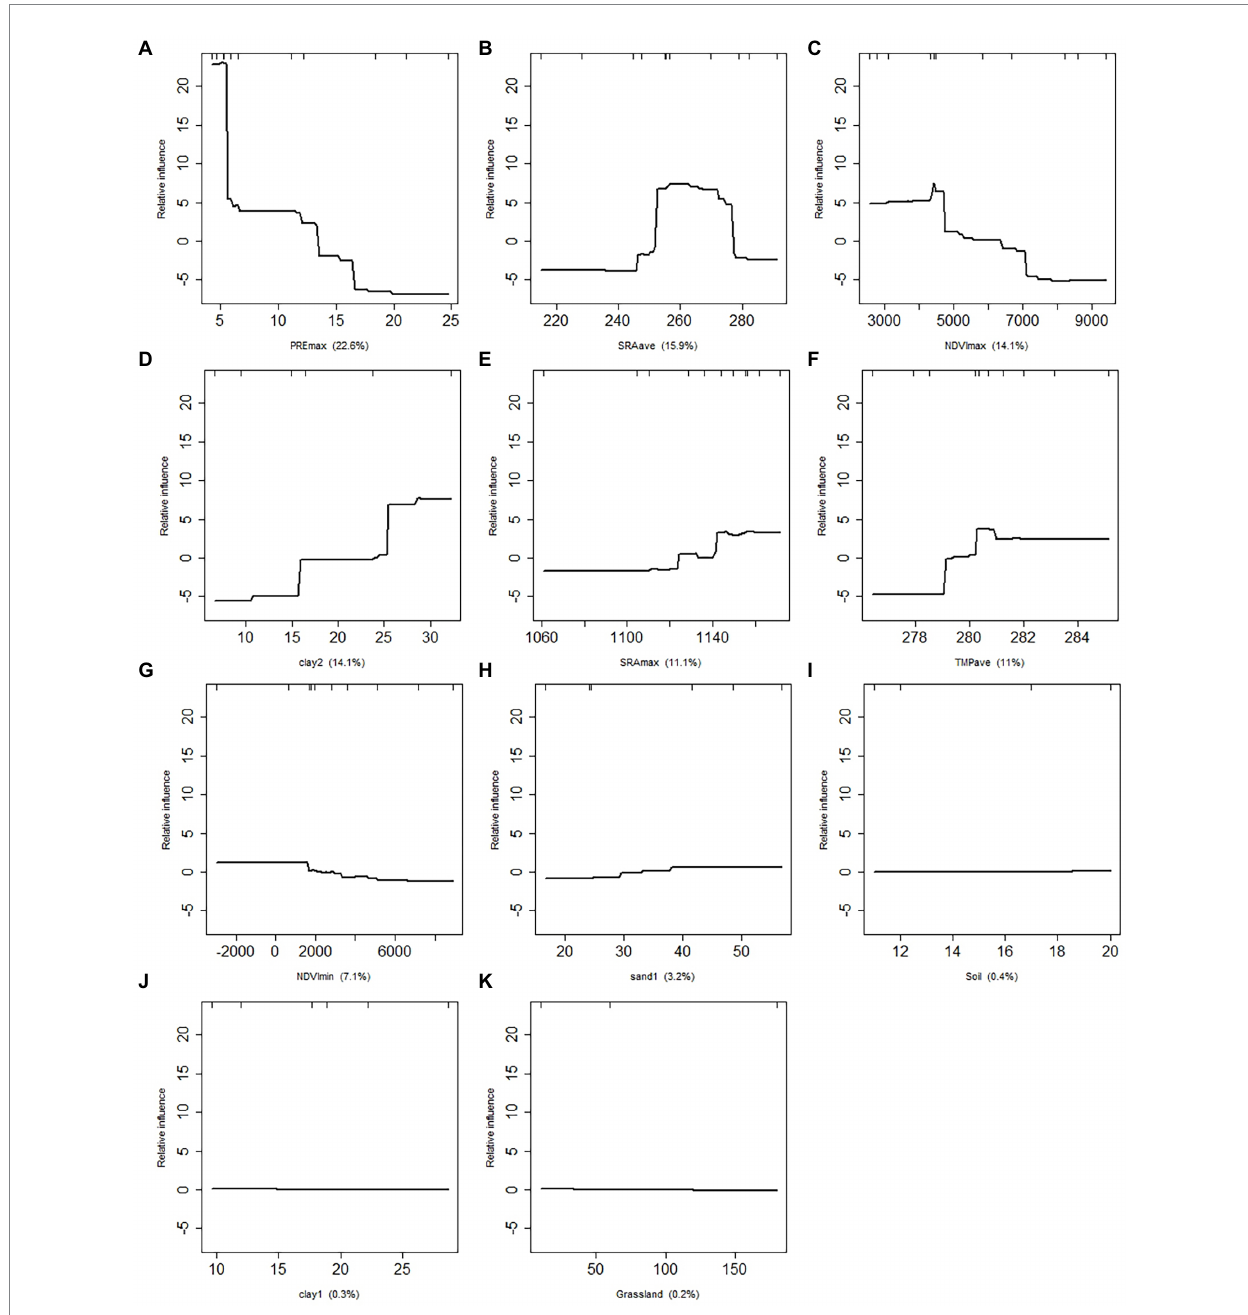
FIGURE 3 The relative contribution of the environment variables. (A-K) refers to the maximum precipitation (PREmax), average solar radiation (SRAave), maximum NDVI (NDVImax), clay concentration of bottom soil (Clay2), maximum solar radiation (SRAmax), average temperature (TEMave), minimum NDVI (NDVImin), sand con-centration of surface soil (Sand1), soil type (Soil), clay concentration of bottom soil (Clay1), and grassland type (Grassland), respectively. X is the value of each environmental